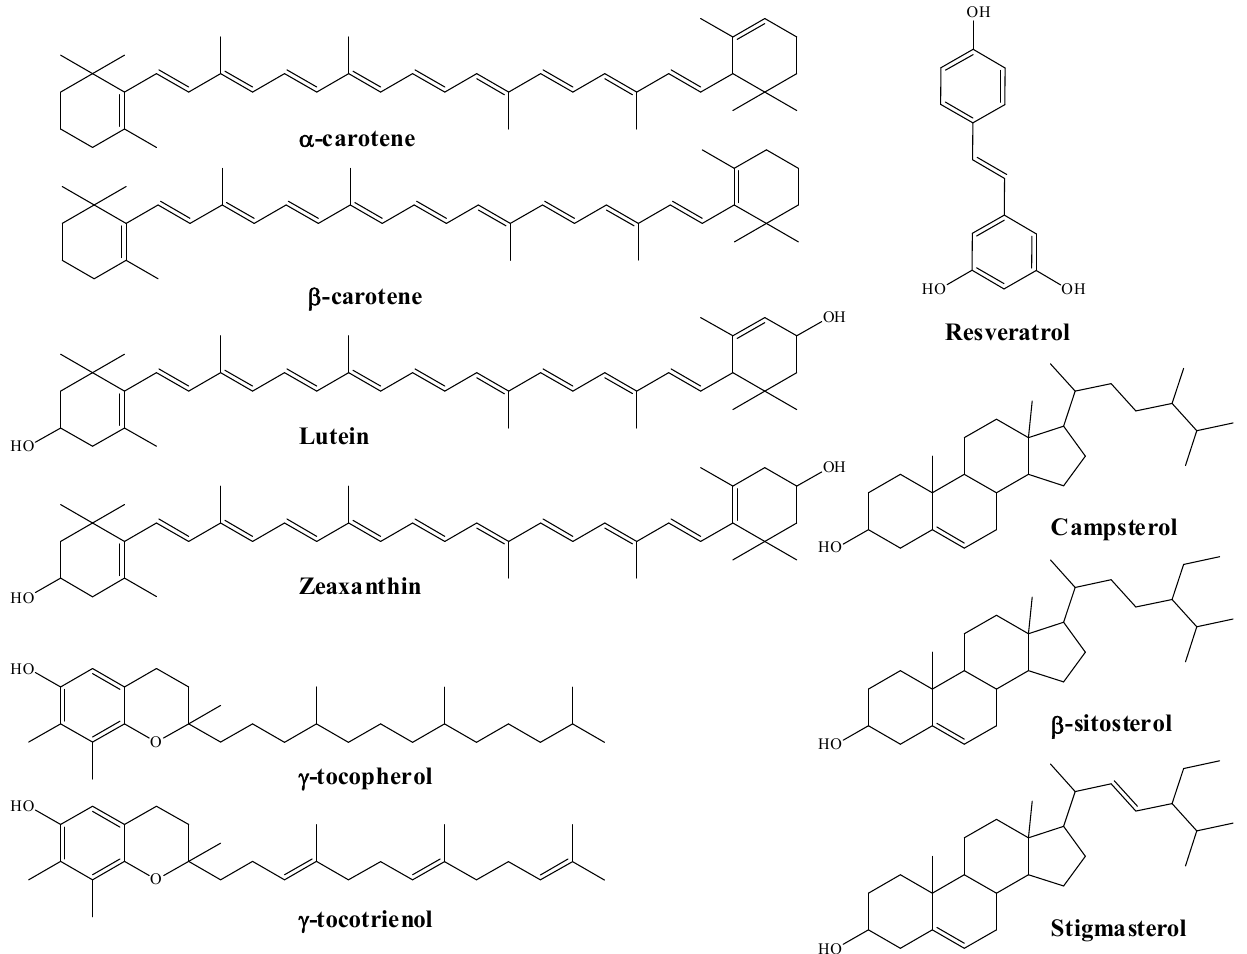
Figure 3. Chemical structures of the major bioactive carotenoids, steroids and resveratrol in pista- chios.